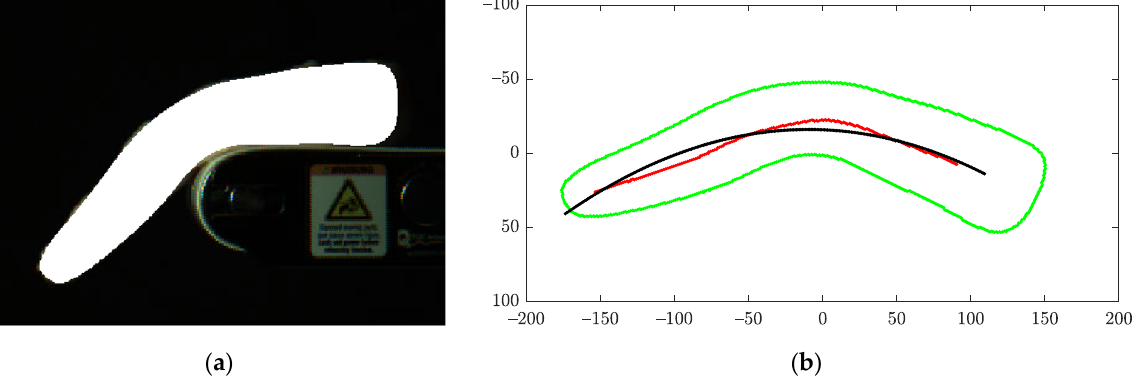
Figure 5. ( a ) Fillet object segmentation; ( b ) Raw (red) and fitted (black) skeletons on a rotated fillet shape